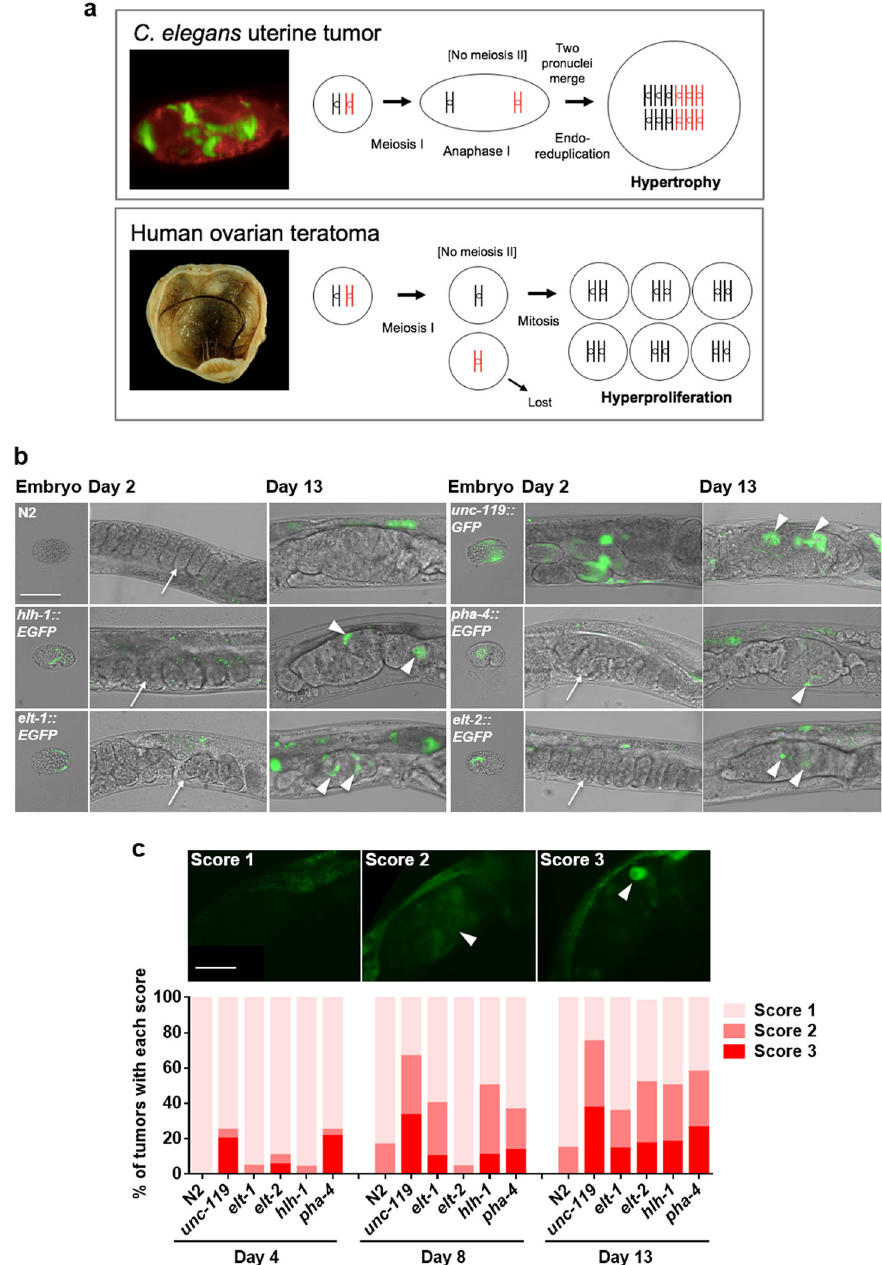
Fig. 3 C. e legans uterine tumors are teratoma-like. a C. elegans uterine tumors and human ovarian teratomas are etiologically similar in that both originate from action in unfertilized immature oocytes of quasi-programs initiated after failure of meiosis II. b , c Expression of